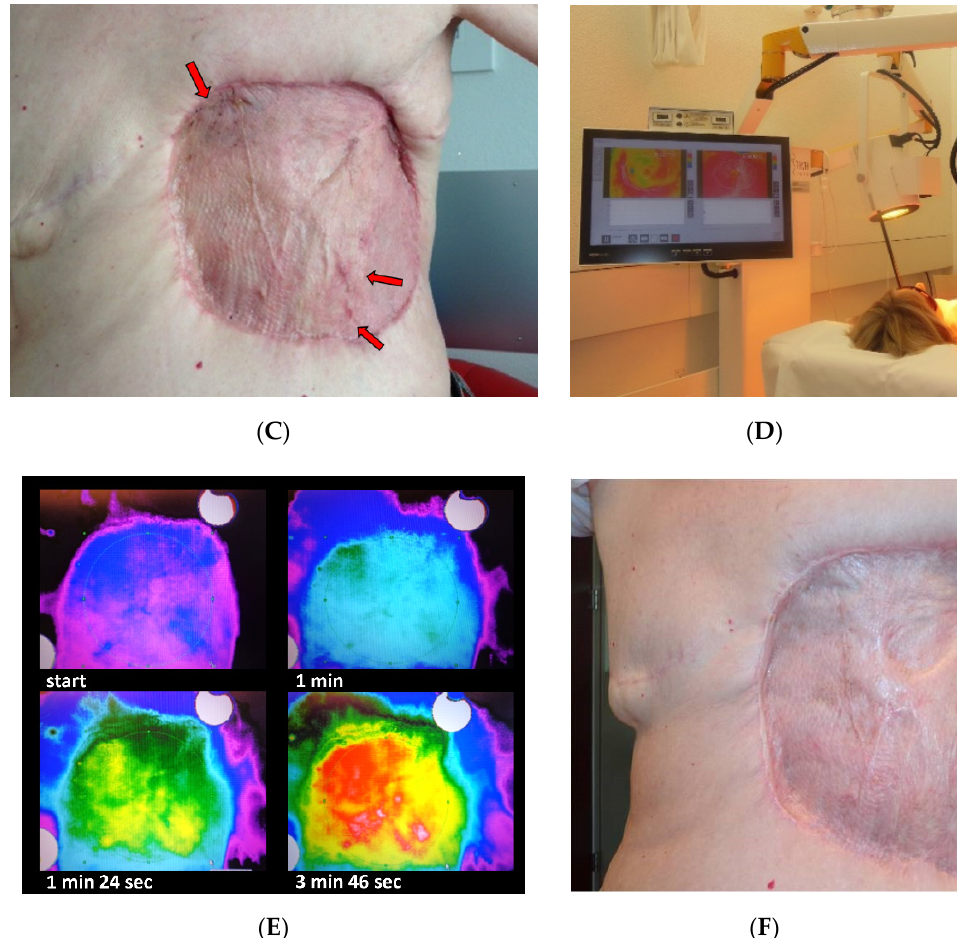
Figure 2. Documentation of patient No. 3. ( A ): Re-analysis of former radiotherapy 5 years prior to RAASB diagnosis: Field documentation of electron boost after tangential Cobalt-60 with 50 Gy (August 2006). ( B ): Initial RAASB, preoperative situation (May 2011). Note, that RAASB occurred outside former electron boost. ( C ) : Third local recurrence within the grafted skin (arrows, May 2014). ( D): During treatment with hydrosun ® TWH 1500. ( E) : Corresponding thermography images during wIRA-hyperthermia: critical regions such as skin transplantation can be controlled visually and protected efficiently without causing burns. ( F ) Follow up 2.5 months after re-RT with 5 × 4 Gy + wIRA-hyperthermia 1×/week (September 2014).